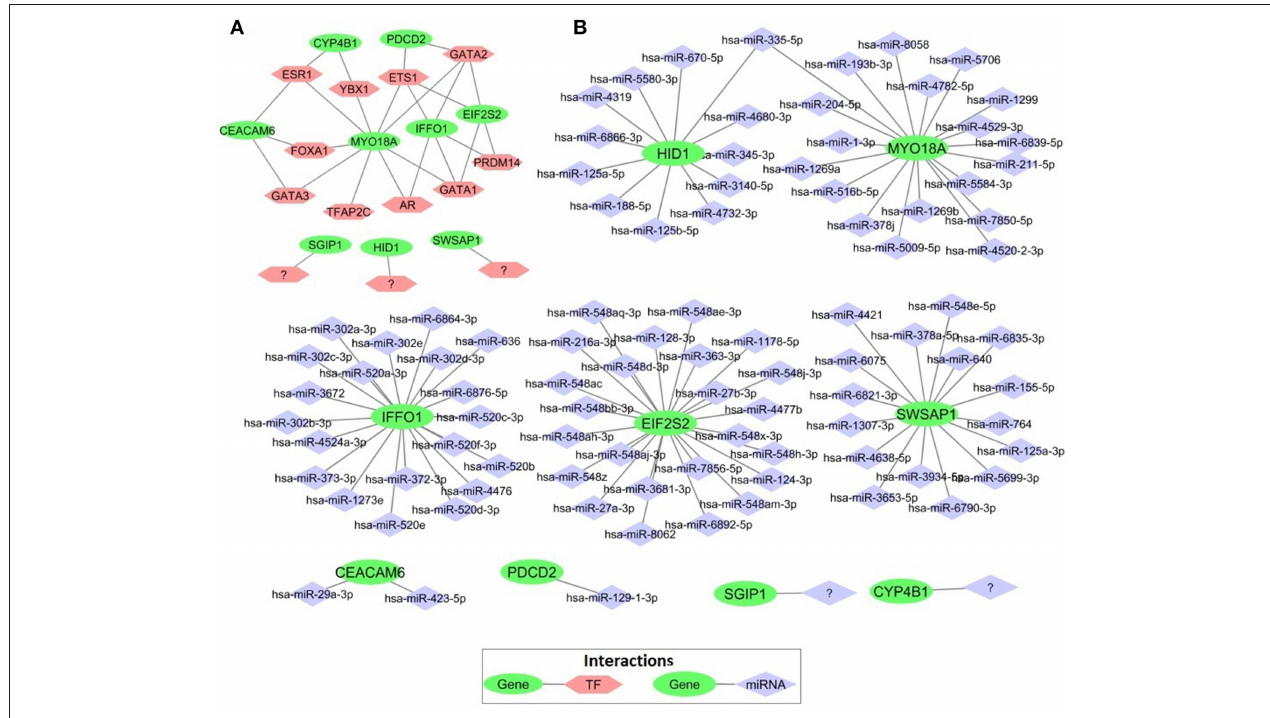
FIGURE 7 | Transcriptional regulators of prognostic genes. (A) Transcription factors that regulate prognostic core module genes (B) microRNAs (miRNAs) regulating the core module